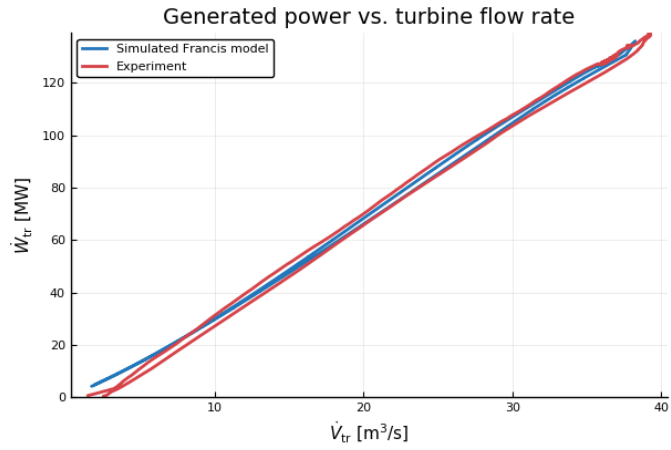
Figure 4. Comparison of the model simulation and experimental power vs. turbine flow rate